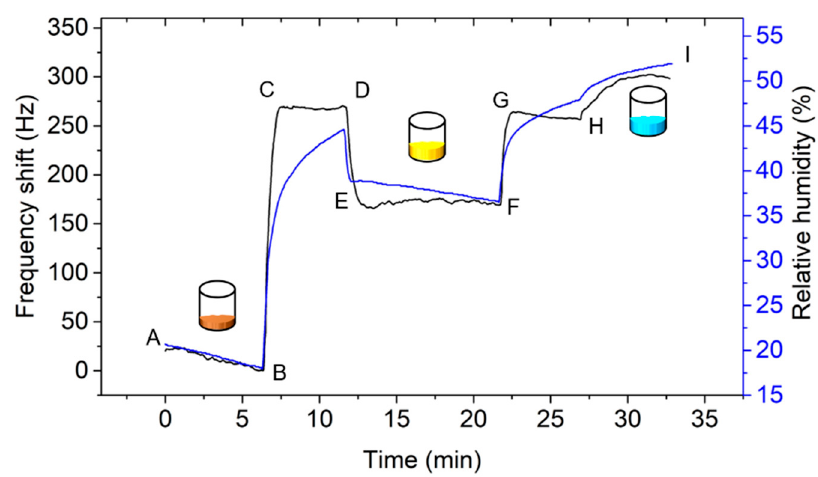
Figure 14. Time-dependent resonant frequency shift ( Δ f 0 ) and rH measurements using an electro- thermal piezoresistive cantilever sensor and a thermohygrometer, respectively, between ambient conditions ( rH of ∼ 44–48%) and defined rH levels P 2 O 5 (brown); CH 3 COOK (yellow) and Mg(NO 3 ) 2 (blue).